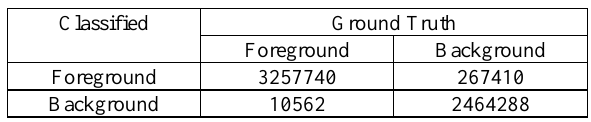
Table 2. The confusion matrix for the result of segmentation with